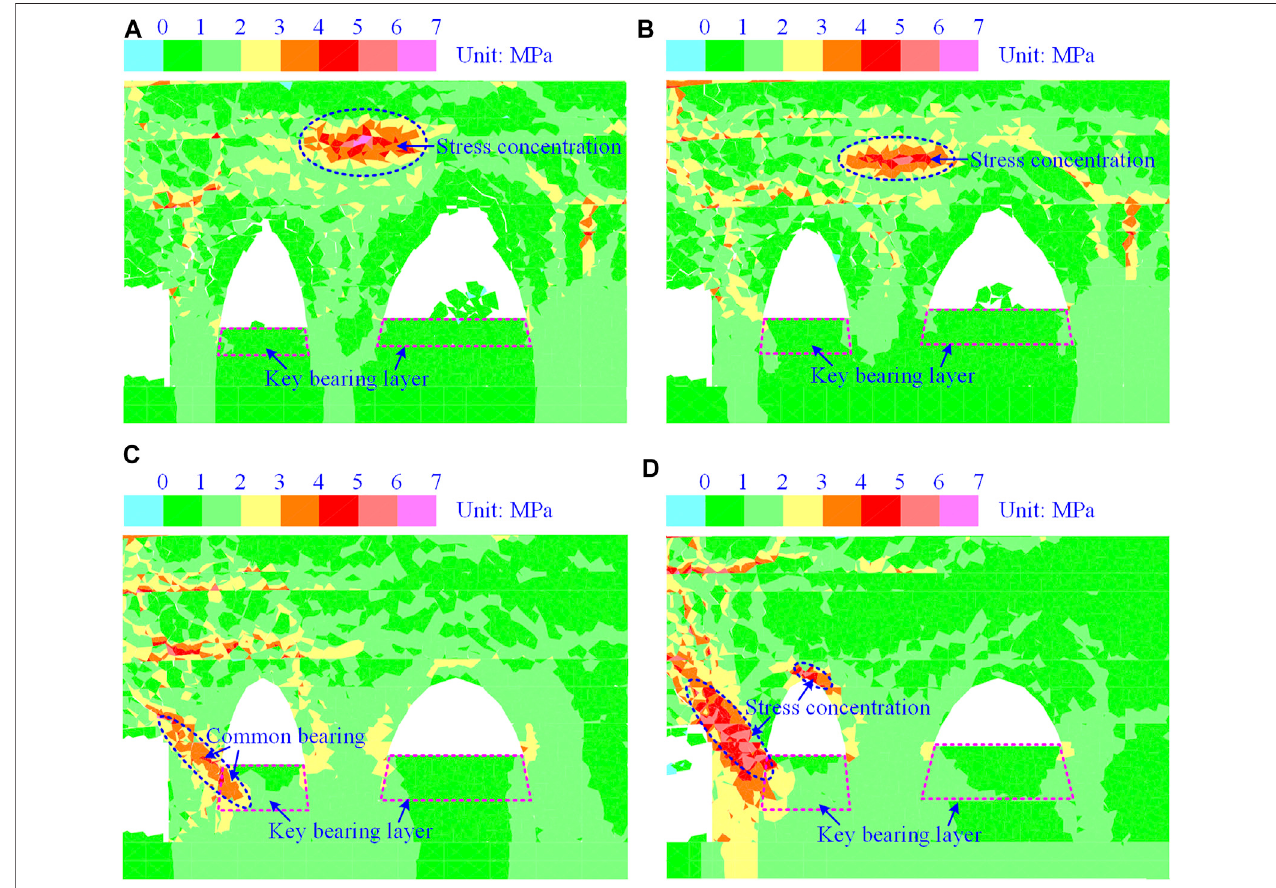
FIGURE 10 | Maximum principal stress contour: (A) 3 m; (B) 4 m; (C) 5 m; (D) 6 m.